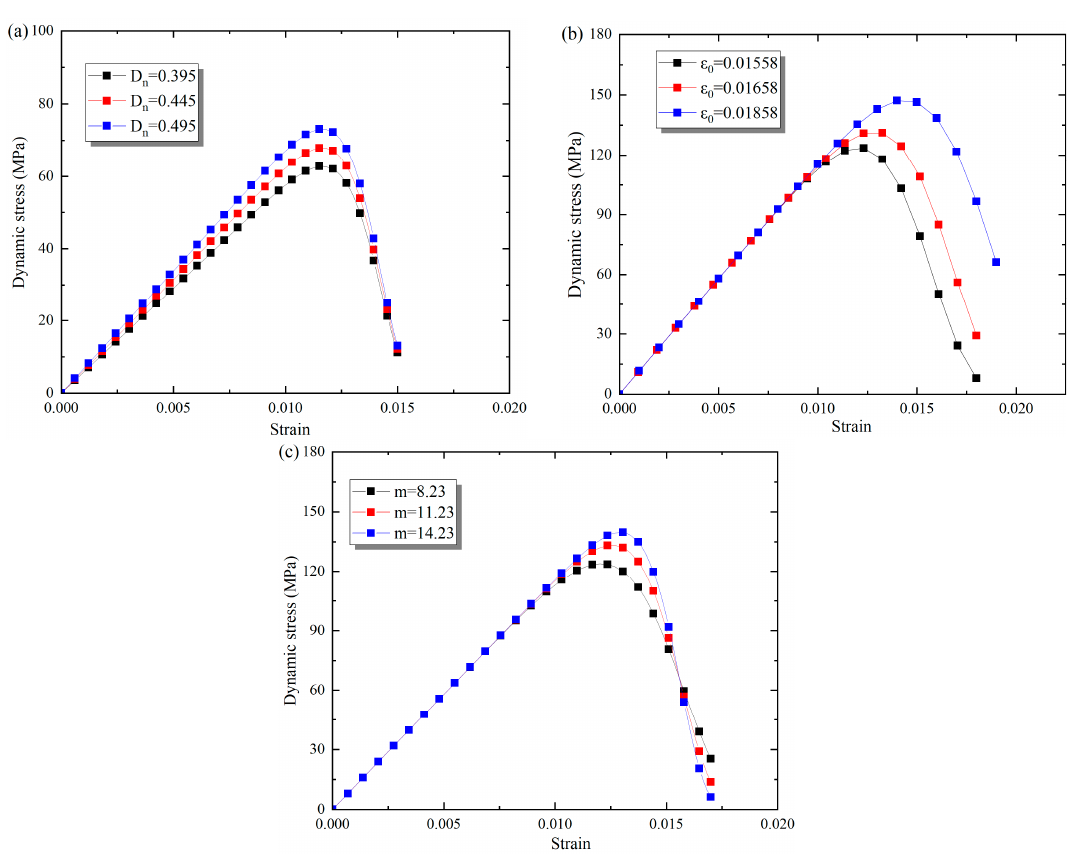
ε ; ( c ) m . Figure 18. Analysis of parameter sensitivity in damage evolution model. ( a ) D n ; ( b ) ε 0 ; ( c )